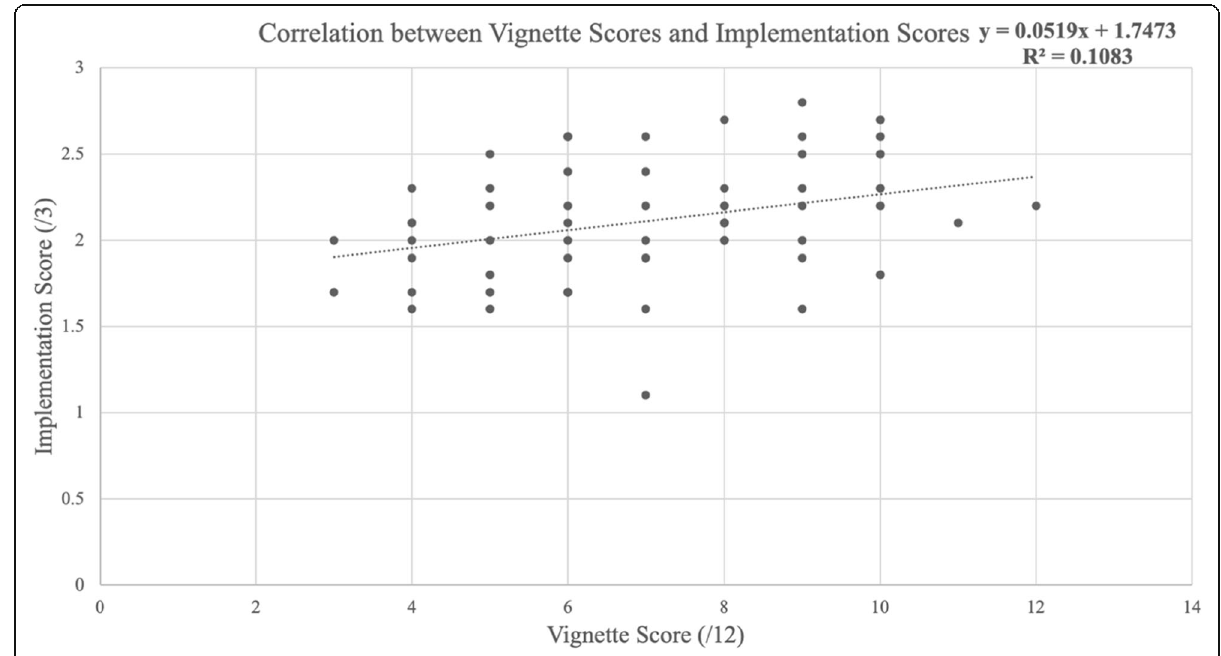
Fig. 2 Correlation Between Implementation Scores and Adaptiveness Vignette Scores ( n = 58)